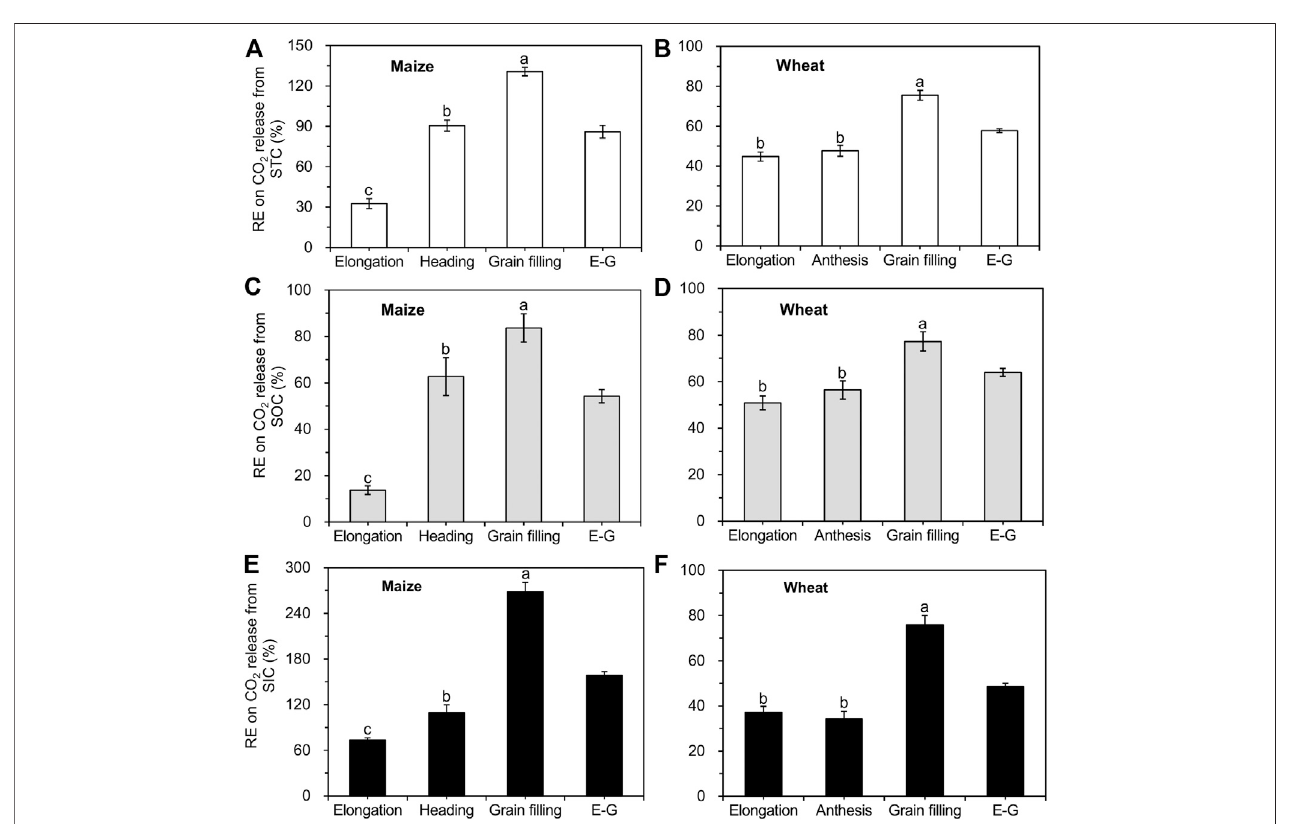
FIGURE 5 | Comparison of the crop rhizosphere effect (RE) on CO 2 release from STC, SOC, and SIC (mean ± SE, n (cid:2) 3 for maize and n (cid:2) 4 for wheat). Note: STC represents soil total C; E-G indicate the growth stages from elongation to grain fi lling.